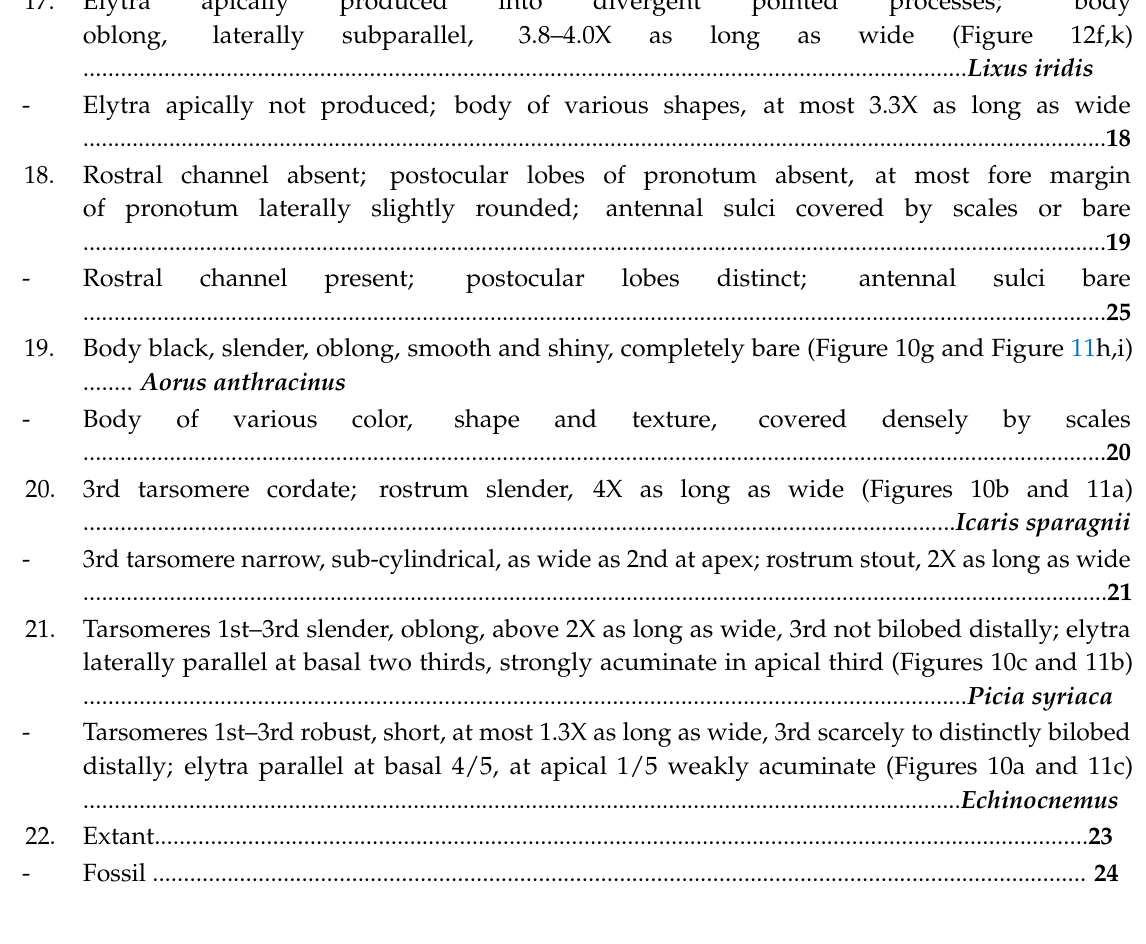
- Rostrum shorter than wide; 3rd tarsomere distinctly wider than 2nd, entirely divided into two rounded lobes; abdomen covered with either piliform scales or combination of round and piliform scales; body oblong, 3.0–7.0 mm long ................................................................................................ 14 14. Fore margin of pronotum laterally without postocular tuft of setae; mandibles without mandibular cusp or round scar; body covered by appressed scales only, laterally with wide, pale lateral stripe of white scales (Figure 12g,i)......................................................................................... Sitona lividipes - Fore margin of pronotum laterally with postocular tuft of setae; mandibles without mandibular cusp or round scar; body covered by appressed, erect and semi-erect scales, laterally without pale lateral stripe of scales (Figure 12h,j) 15. Rostrum anteriorly tapering at least from antennal insertion, apically pointed; on Melilotus albus - 16. Metafemur with anteromedian denticle, male protibia without denticle medially; rostrum in lateral view less curved at base and gradually tapering towards apex; part of body covered with yellowish scales, scales truncated apically (Figure 14g,i–k) - All femora without denticles, male protibia with strong denticle medially; rostrum in lateral view strongly curved at base and strongly tapering from antennal insertion place toward apex; upper part covered with whitish scales, scales pointed apically (Figure 14h,l–n)